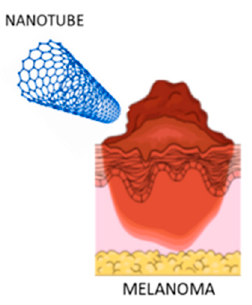
Figure 4. Interaction between carbon nanotubes (CNTs) and melanoma.